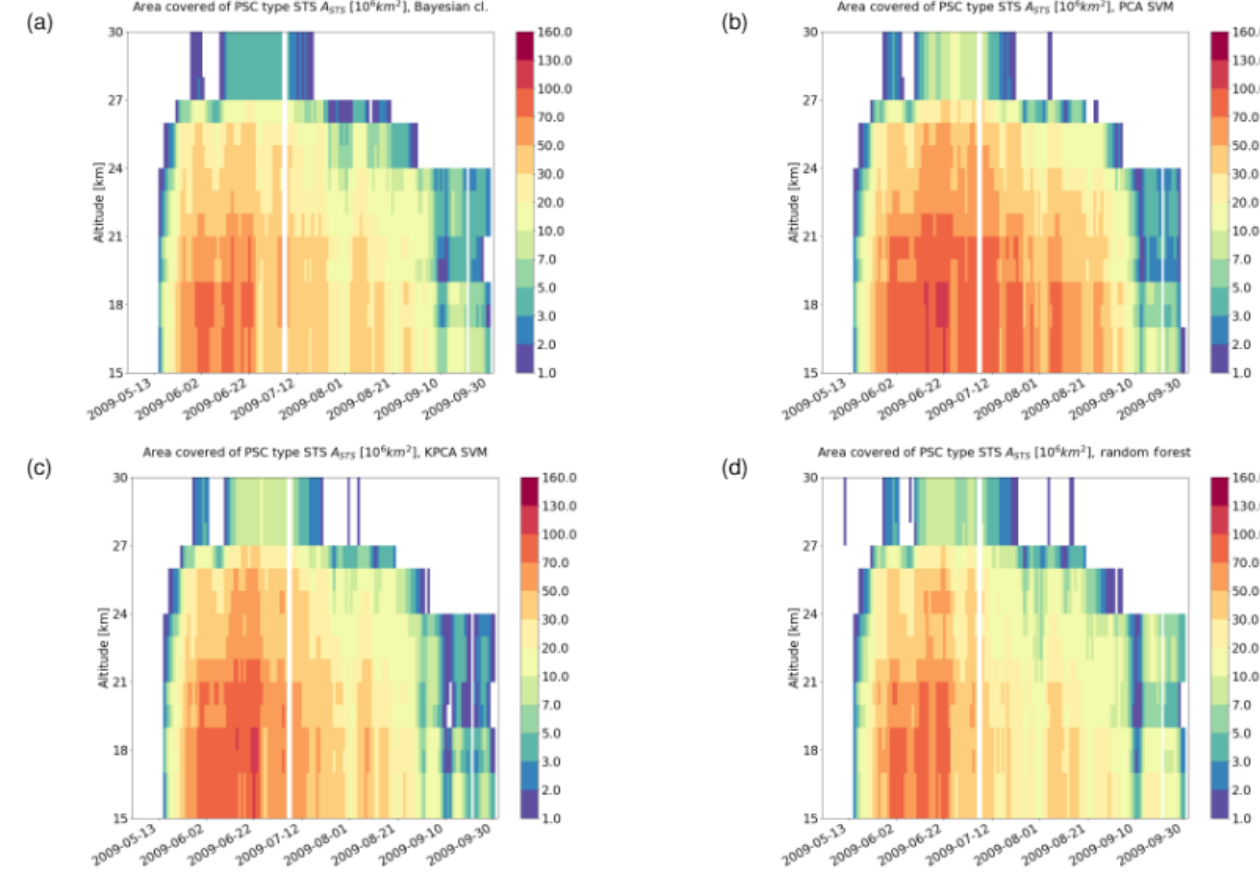
Figure 11. Area covered by STS clouds from May to September 2009 in the Southern Hemisphere based on results of (a) the Bayesian classifier, (b) the PCA + SVM classifier, (c) the KPCA + SVM classifier, and (d) the RF classifier. The bins span a length of 1d in time and 1km in altitude. A horizontal (3d) and vertical (3km) moving average has been applied for the sake of a smoother